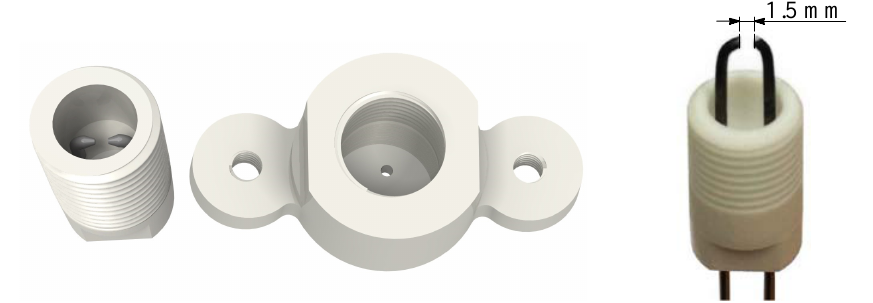
Figure 1. CAD reconstruction of the home-made Plasma Synthetic Jet (PSJ) actuator ( left ), and detail of the electrodes location ( right